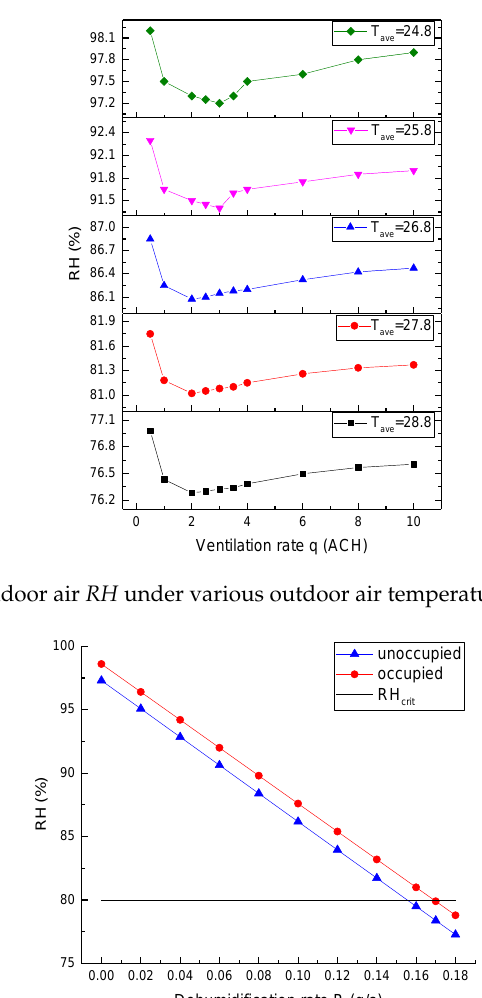
Figure 11. The highest indoor air RH under different heating rates in the unoccupied home. 4. Discussion RH crit is found to be a constant in this study, i.e., 80%, because the indoor air temperature is normally higher than 20 °C during the plum rain season. Dehumidification is indispensable for controlling indoor air RH in both the unoccupied home and the occupied home. It is noted that removing moisture is crucial in humidity control in an indoor environment, especially in humid climates [29]. When the dehumidification rate rises up by 0.02 g/s, both of the indoor air RH in the unoccupied home and occupied home drop down by 2.2%, which could be achieved by various dehumidification methods. For instance, a solid desiccant dehumidification system [30] and a liquid desiccant dehumidification system [31] could be combined with the air conditioning system, or a high-efficiency household dehumidifier could also be used in homes [28]. In recent years,